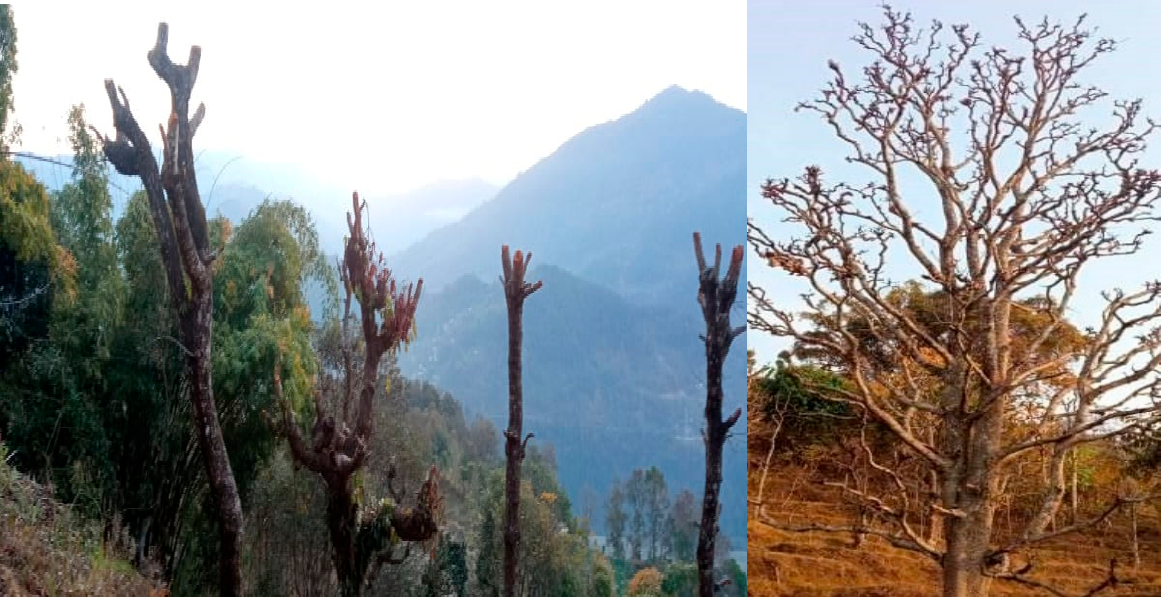
Figure 7: Some regenerative forestry practices: The first photo depicts firewood trees with coppicing practice (lopping branches in every three-year cycle). The second photo depicts an 84-year-old fodder tree that the owner lops its branches each year.